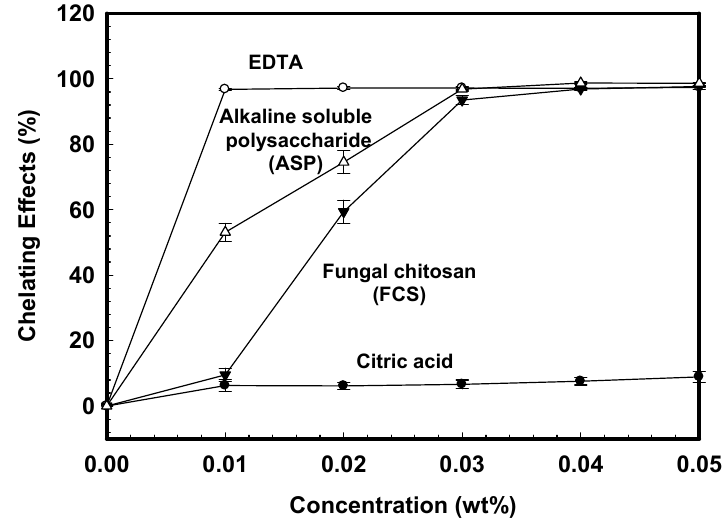
Figure 2. The concentration dependence of chelating effects for various irrigation solutions.